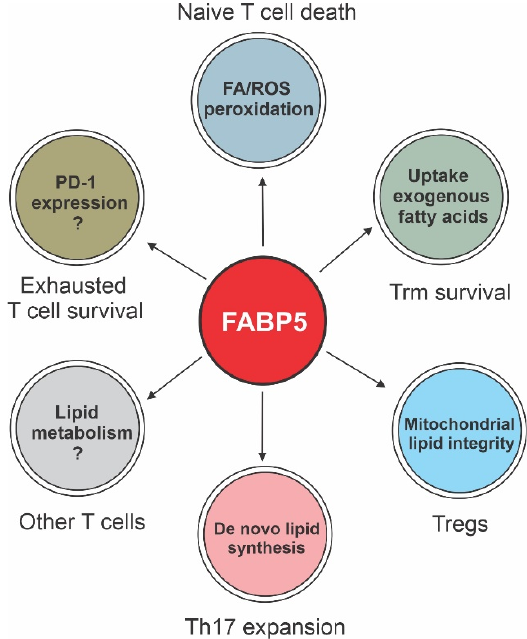
Figure 4. Role of FABP5 in regulating lipid metabolism in different subsets of T cells. As the main lipid chaperone in T cells, FABP5 facilitates the uptake of exogenous fatty acids and de novo lipid synthesis, thus promoting mitochondrial FAO and membrane lipid synthesis, respectively. In general, FABP5 deficiency is associated with enhanced immune suppressive activity of Tregs and reduced survival of Trm and exhausted T cells in the TME, which contribute to elevated tumor growth in FABP5 -/- mice on the LFD. Notably, naïve T cells mainly rely on glucose for their survival, while uptake of exogenous fatty acids, especially LA, by FABP5 promotes mitochondrial ROS and lipid peroxidation, inducing naïve T cell death; thus, mice on HFD rich in LA exhibit reduced CD8 + T cells in the TME, leading to excecated tumor growth. The role of FABP5 in mediating lipid metabolism and function in other T cell subsets (e.g., Th17 or γδ T cells) in the TME needs further